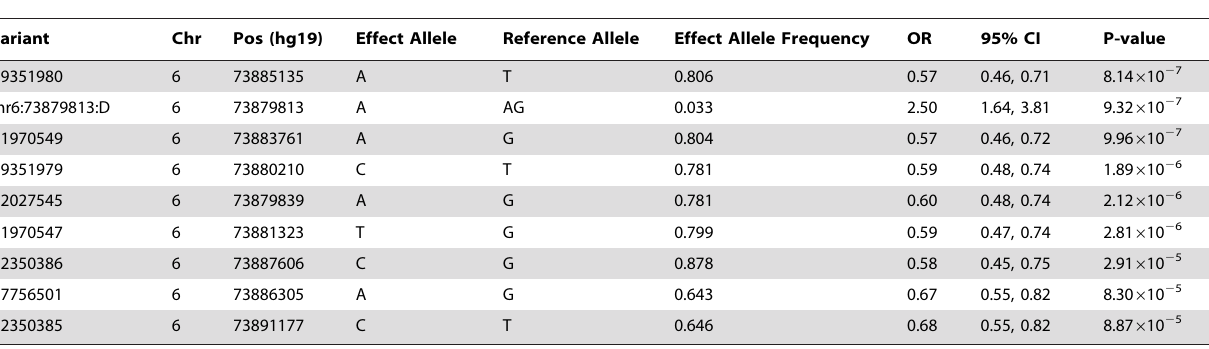
Table 6. Imputed variants in gene KCNQ5 with p-value , 10 2 4 in the African American cohort.